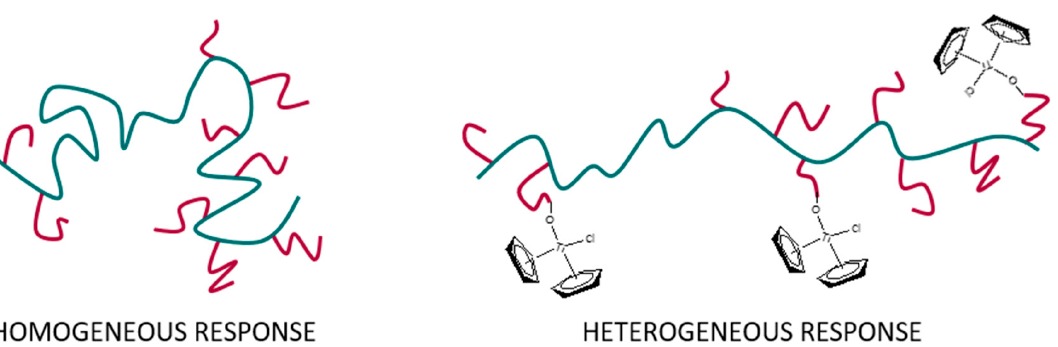
Figure 5. Phase transition temperatures analyzed by UV–vis spectroscopy ( A ) and calorimetry ( B ) for all polymeric solutions (1 wt.%).